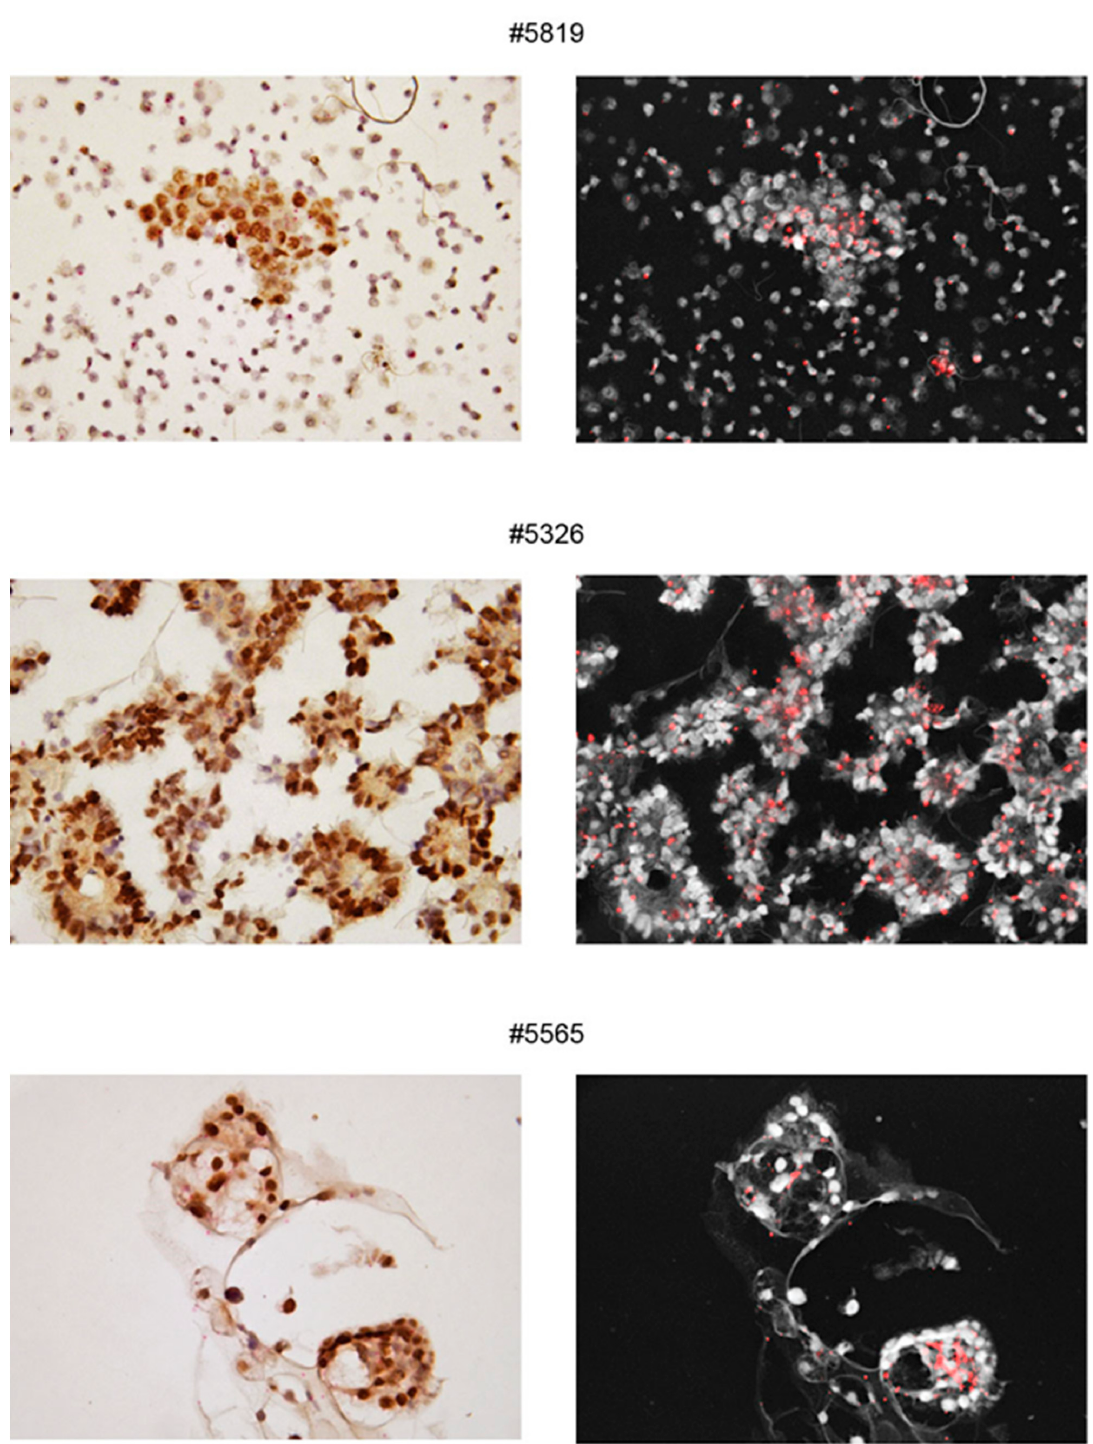
Figure 6. RNAscope showing ACTA2 transcripts (red dots in panels on the left, better visible as fluorescent dots in panels on the right) encoding α SMA in the epithelial cells of bulk ascites samples. Cells are stained with primary PAX8 MAb followed by HRP and DAB substrate and nuclei were counterstained with hematoxylin. Numbers on top of panels correspond to the Profiling protocol numbers of the collected ascites. Details of each #case are in Supplementary Table